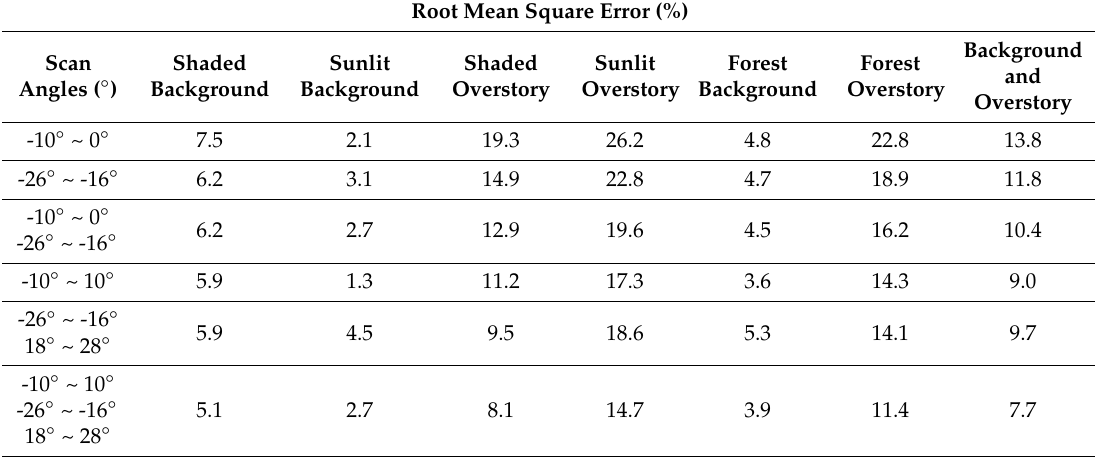
Table 5. Root mean square error of four forest component proportions between ALS- and 3DSmax-based results under di ff erent scan angles in